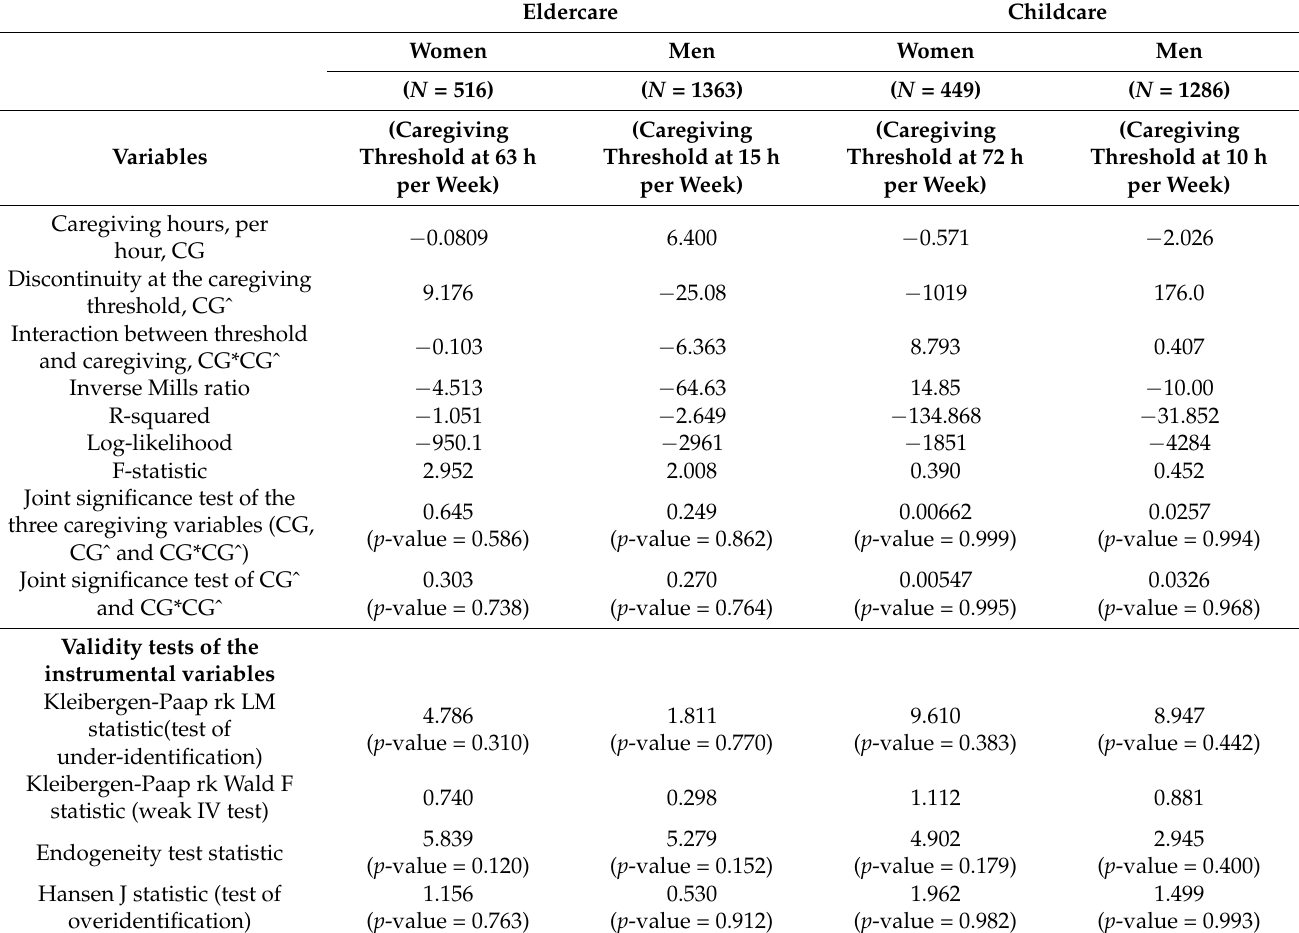
Table A2. A secondary analysis on eldercare and childcare using the four instrumental